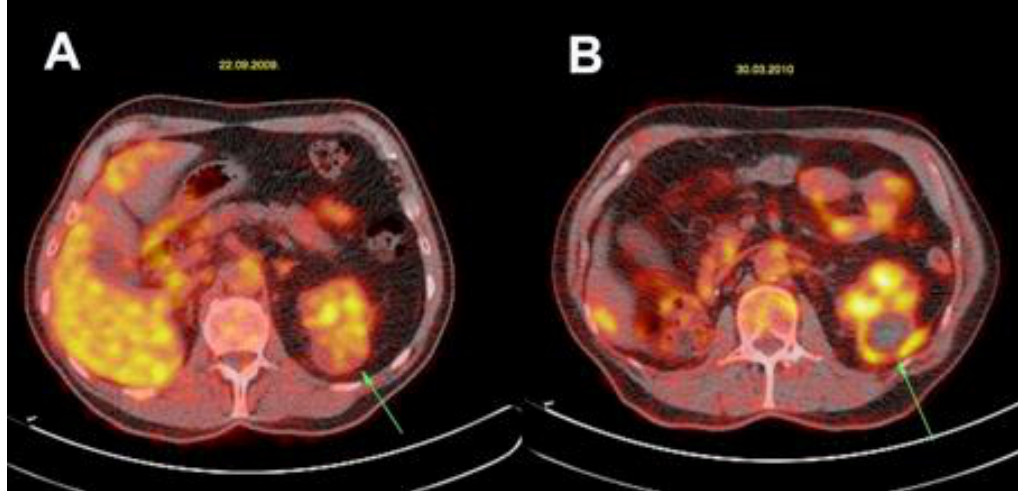
Figure 1. Patient number 2, an example of 18 F-FDG-distribution in a renal mass before ( A ) and after 5 months cryoablation ( B ) at PET-CT. The light active hypointense uptake in the tumor in the left kidney before cryoablation (green arrow panel A ) has changed to a hypometabolic area after ablation (green arrow panel B ). The activity around the ablated tumor in the perirenal fat is possibly due to inflammatory tissue reaction. A contrast-enhanced CT scan as a control showed no enhancement of the ablation zone after